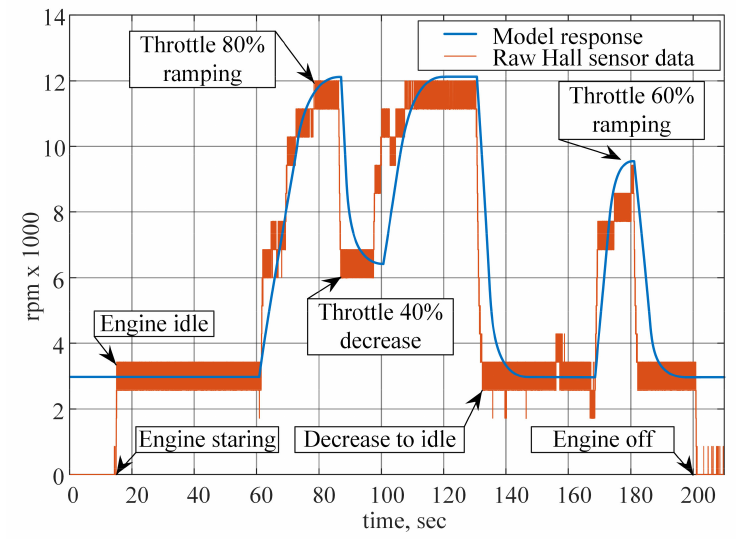
Figure 16. Model